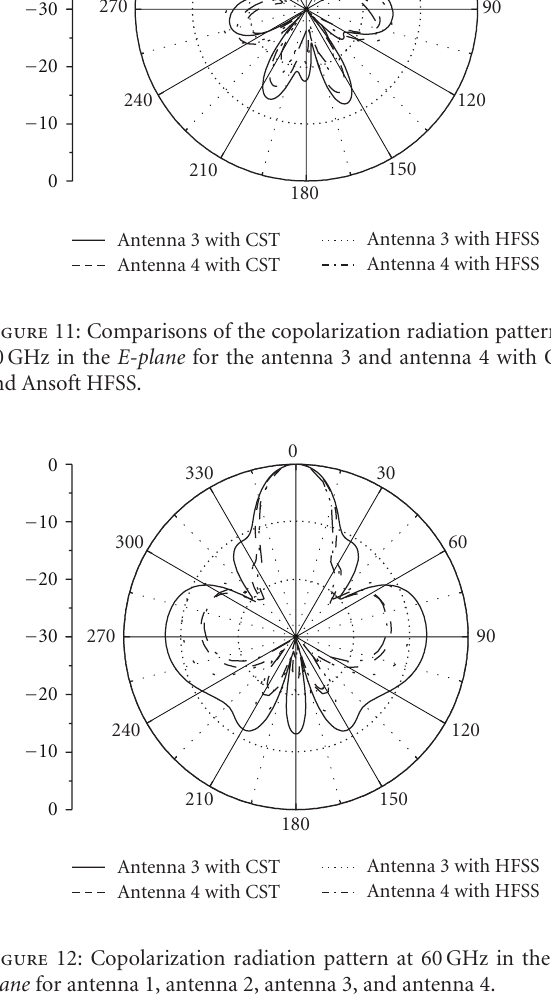
Figure 12: Copolarization radiation pattern at 60GHz in the H- plane for antenna 1, antenna 2, antenna 3, and antenna